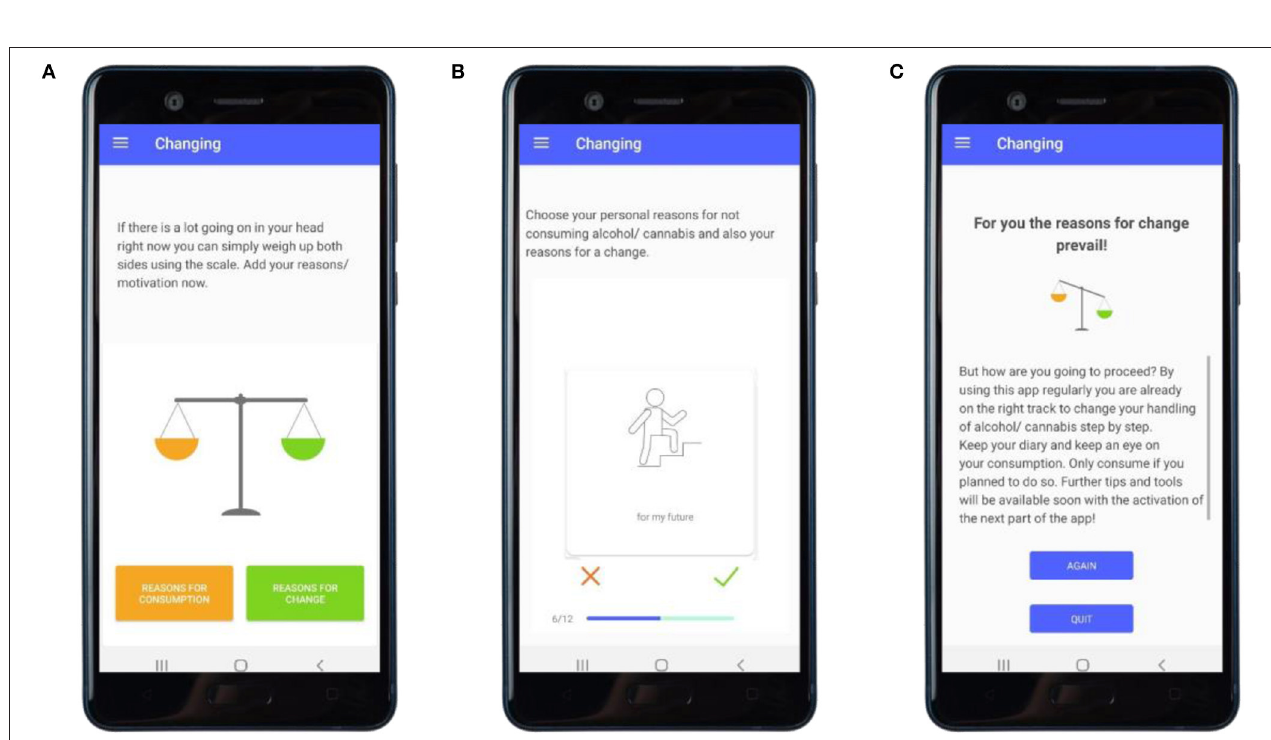
FIGURE 4 | “Changing”: promoting motivation to change. (A) User has reflected on reasons for the use of substances and reasons for reducing the use of substances and starts to balance these in the motivational scale exercise. (B) User choses reasons for the use of substances and reasons for reducing the use of substances. (C) User receives feedback on personal reasons for substance use and reasons for changing one’s substance use behavior.